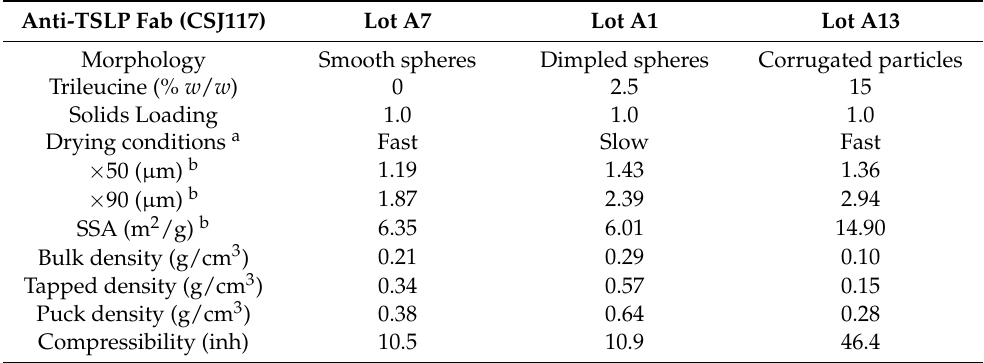
Table 3. Process conditions and micromeritic properties of three formulations comprising 50% w / w of an anti-human thymic stromal lymphopoietin (TSLP) antibody fragment (CSJ117) [93,94]. Adapted with permission from Virginia Commonwealth University and Respiratory Drug Delivery,